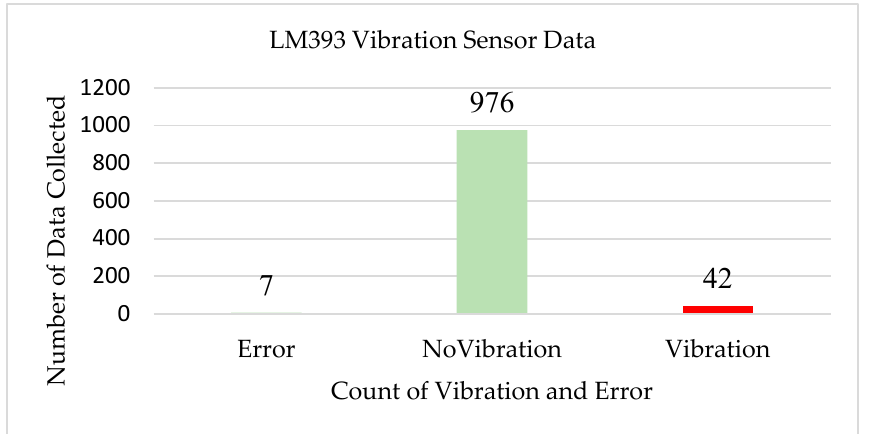
Figure 6. Test results for LM393 vibration